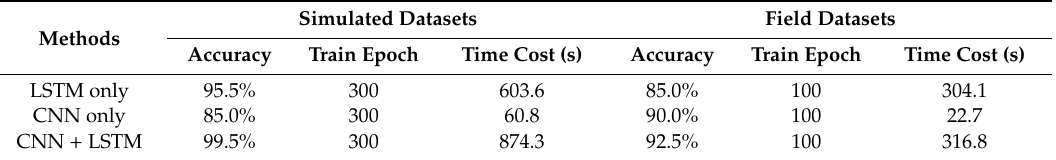
Table 4. Comparison of different networks on overall accuracy and training time cost.